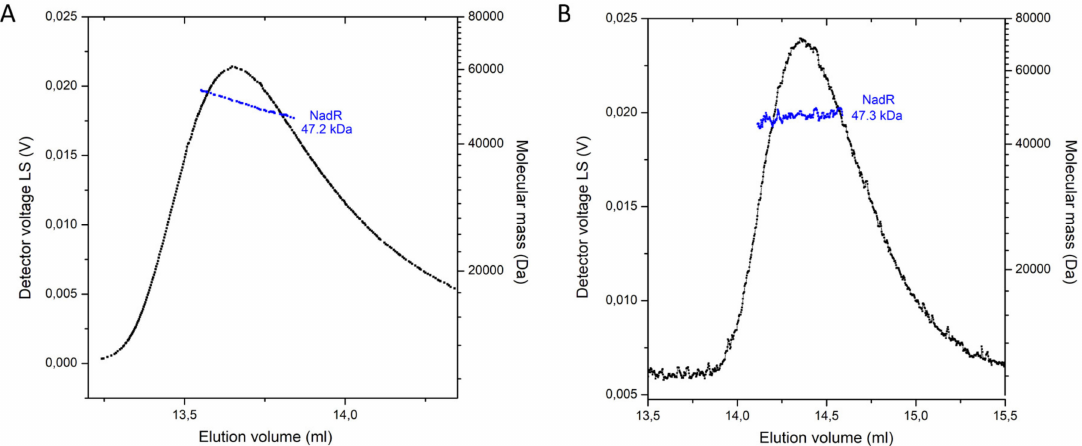
Figure 5. Oligomeric state of the NadR protein from L. lactis in solution. SEC-MALLS analysis of NadR without substrates ( A ) and in the presence of 5 mM ATP and 1 mM NMN ( B